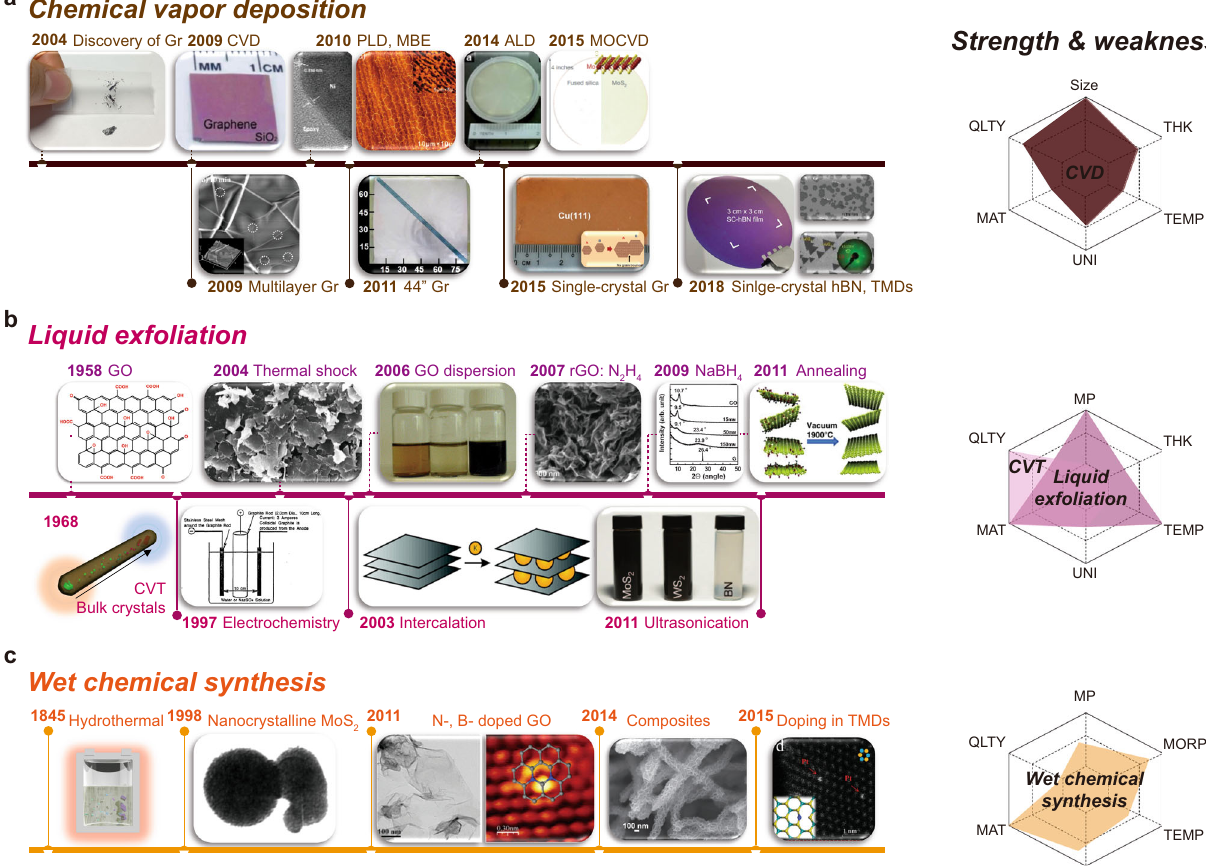
Fig. 2 Historical landmarks in the development of three representative synthesis techniques. Lefthand panels show timelines of milestones for a chemical vapor deposition (CVD), b liquid exfoliation, and c wet chemical synthesis methods. The abbreviations correspond to: metal-organic CVD (MOCVD), graphene (Gr), graphite oxide (GO), reduced GO (rGO), and molybdenum disul fi de (MoS 2 ). Righthand panels show the corresponding strengths and weaknesses of these methods in terms of mass production (MP), thickness controllability (THK), temperature variation (TEMP), uniformity (UNI), material diversity (MAT), crystal quality (QLTY), morphology (MORPH). Panel a reprinted from refs. 9,17 , American Association for the Advancement of Science, ref. 15 , Nature, refs. 7,10,12 , Wiley, ref. 5 , American Institute of Physics, ref. 6 , Royal Society of Chemistry, and ref. 11 , World Scienti fi c. Panel b reprinted from refs. 26,27 , American Association for the Advancement of Science, refs. 22,23 , Wiley, refs. 19 – 21 , Elsevier, and ref. 24 , Institute of Electrical and Electronic Engineers. Panel c reprinted from ref. 28 , Elsevier, ref. 30 , American Chemical Society, ref. 31 , Elsevier, and ref. 32 , Royal Society of